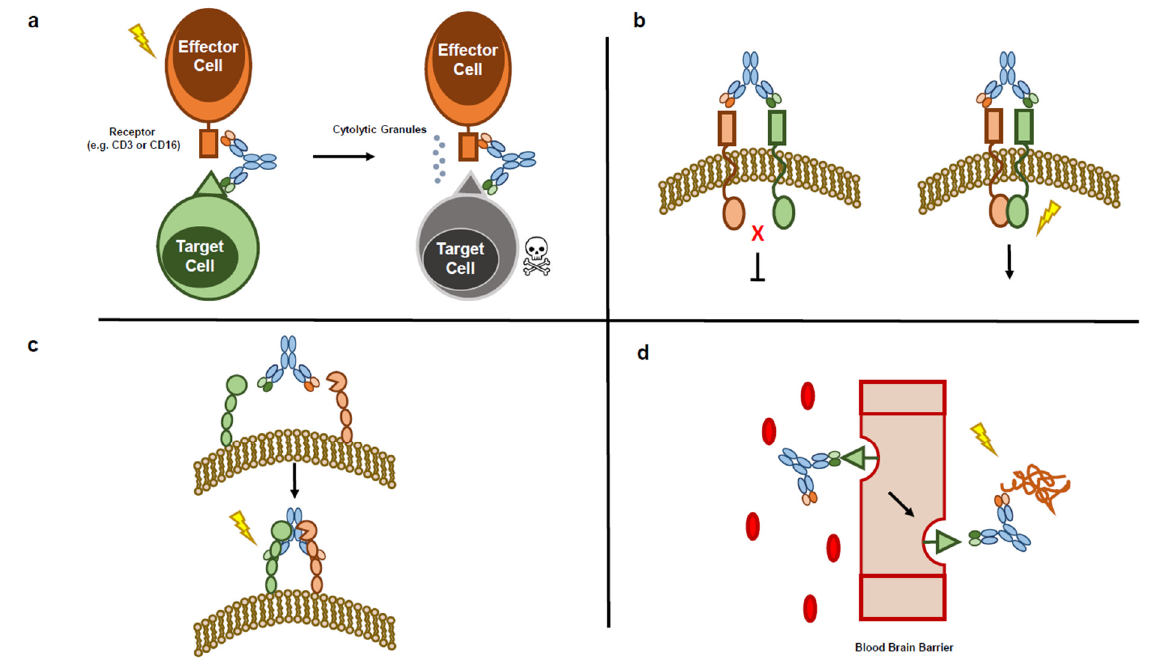
Figure 2. Mechanisms of actions of BsAb: ( a ) Schematic diagram of cell-bridging BsAb MoA (e.g., TDB or NK-recruiting BsAb); ( b ) Schematic diagram of receptor activating/inhibiting MoA (e.g., receptor dimerization inhibitor or activator); ( c ) Schematic diagram of cofactor mimicking MoA (e.g., emicizumab); and ( d ) Schematic diagram of “homing” BsAb MoA (e.g., blood brain barrier crosser).